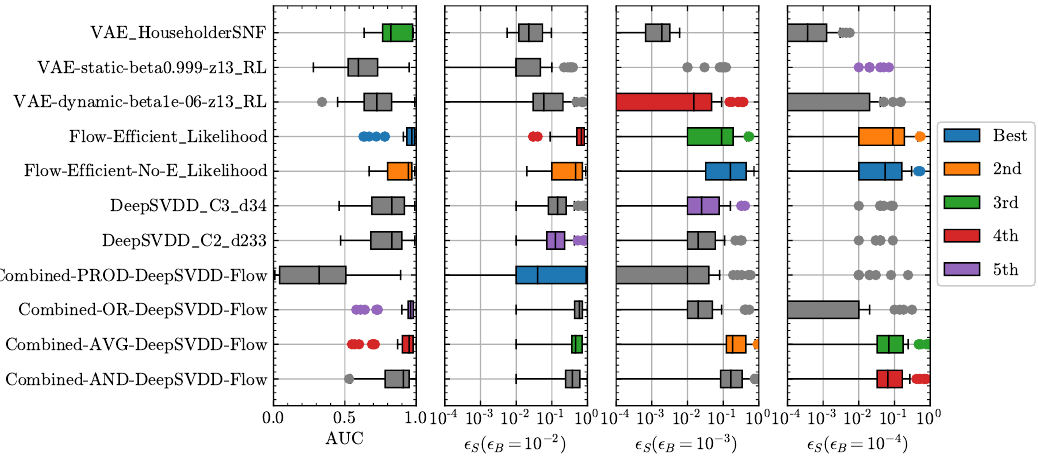
Figure 12: Box plots summarizing the anomaly detection techniques applied to all of the new physics signals. The colors denote the technique that have the top score the most times.